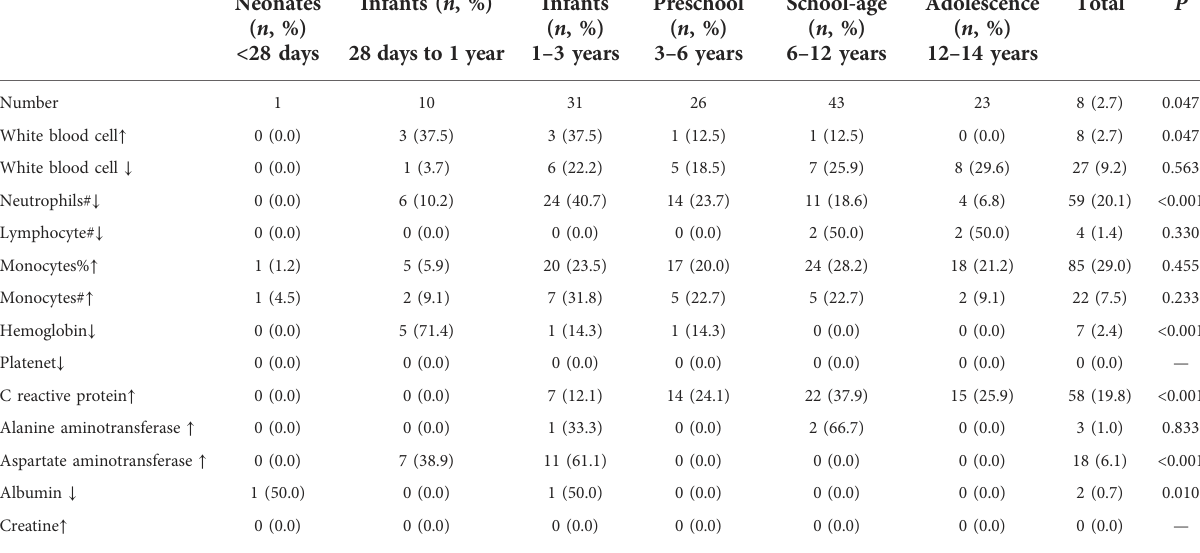
TABLE 3 The distribution of abnormal lab examinations between age groups among children with omicron infection.